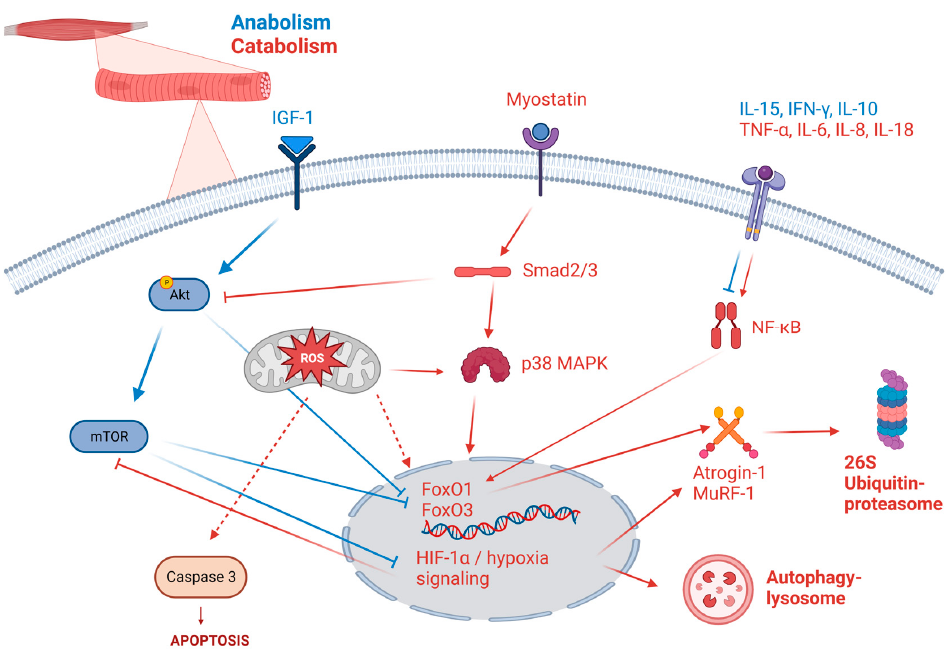
Figure 2. Alteration of the hypertrophy/atrophy balance leading to impaired protein turnover in COPD myocytes. Anabolic (hypertrophic) processes are represented in blue and catabolic (atrophic) in red. The chosen pathways have been identified as dysregulated in COPD patients or experimental models of COPD. IFN, interferon. IGF, insulin growth factor. IL, interleukin. MAPK, mitogen-activated protein kinase. Created with BioRender.com (accessed on 1 February 2023). Table 1. Characterization of locomotor skeletal muscle dysfunction in COPD rodent models.